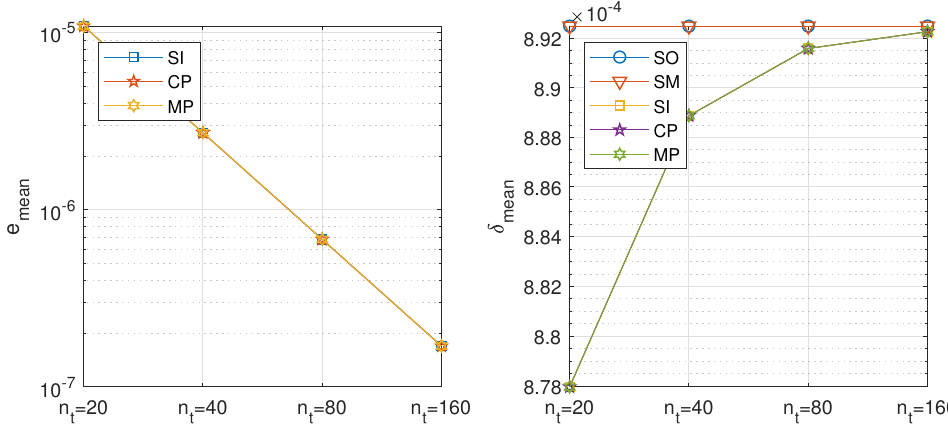
Figure 6. Diffusion problem, balanced decomposition. Precision of the proposed methods: sequential iterative SI, classical parallel CP, and modern parallel MP, compared with the classical ones: sequential operator SO and Strang–Marchuk SM, with second order approximations for the spatial derivatives for different number of time steps.